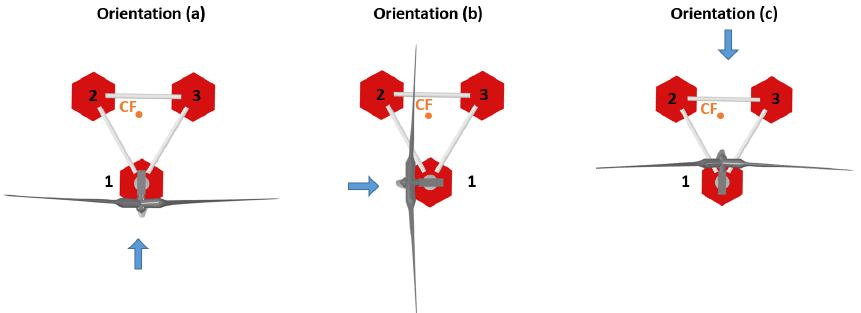
Figure 12. Top view of three different turbine orientations with respect to the platform, in the case of Platform A. The blue arrow shows the incoming wind direction. Numbers identify the platform columns.